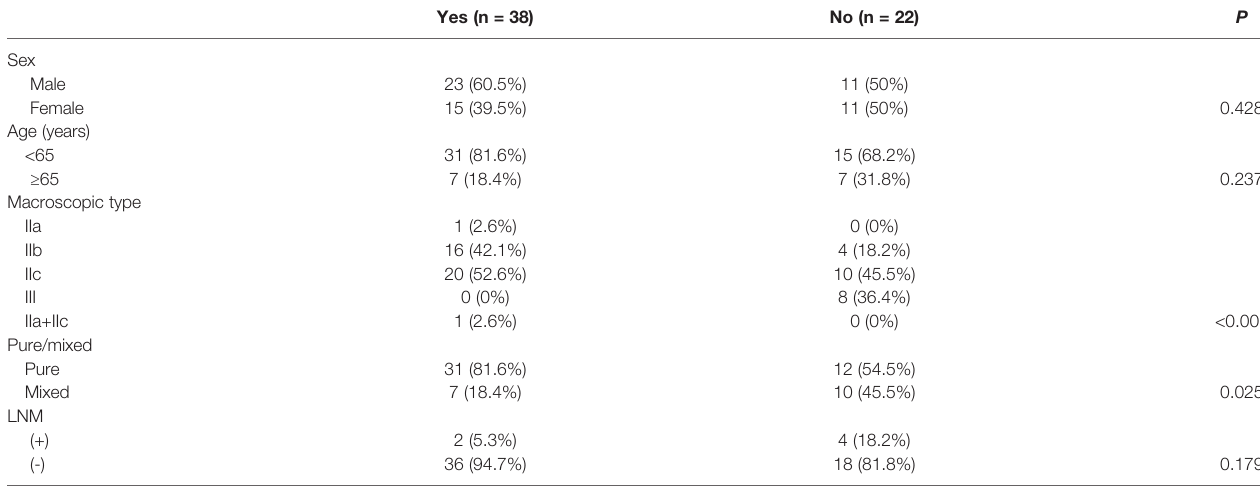
TABLE 7 | Clinicopathological characteristics of SRCC according to ESD indication.